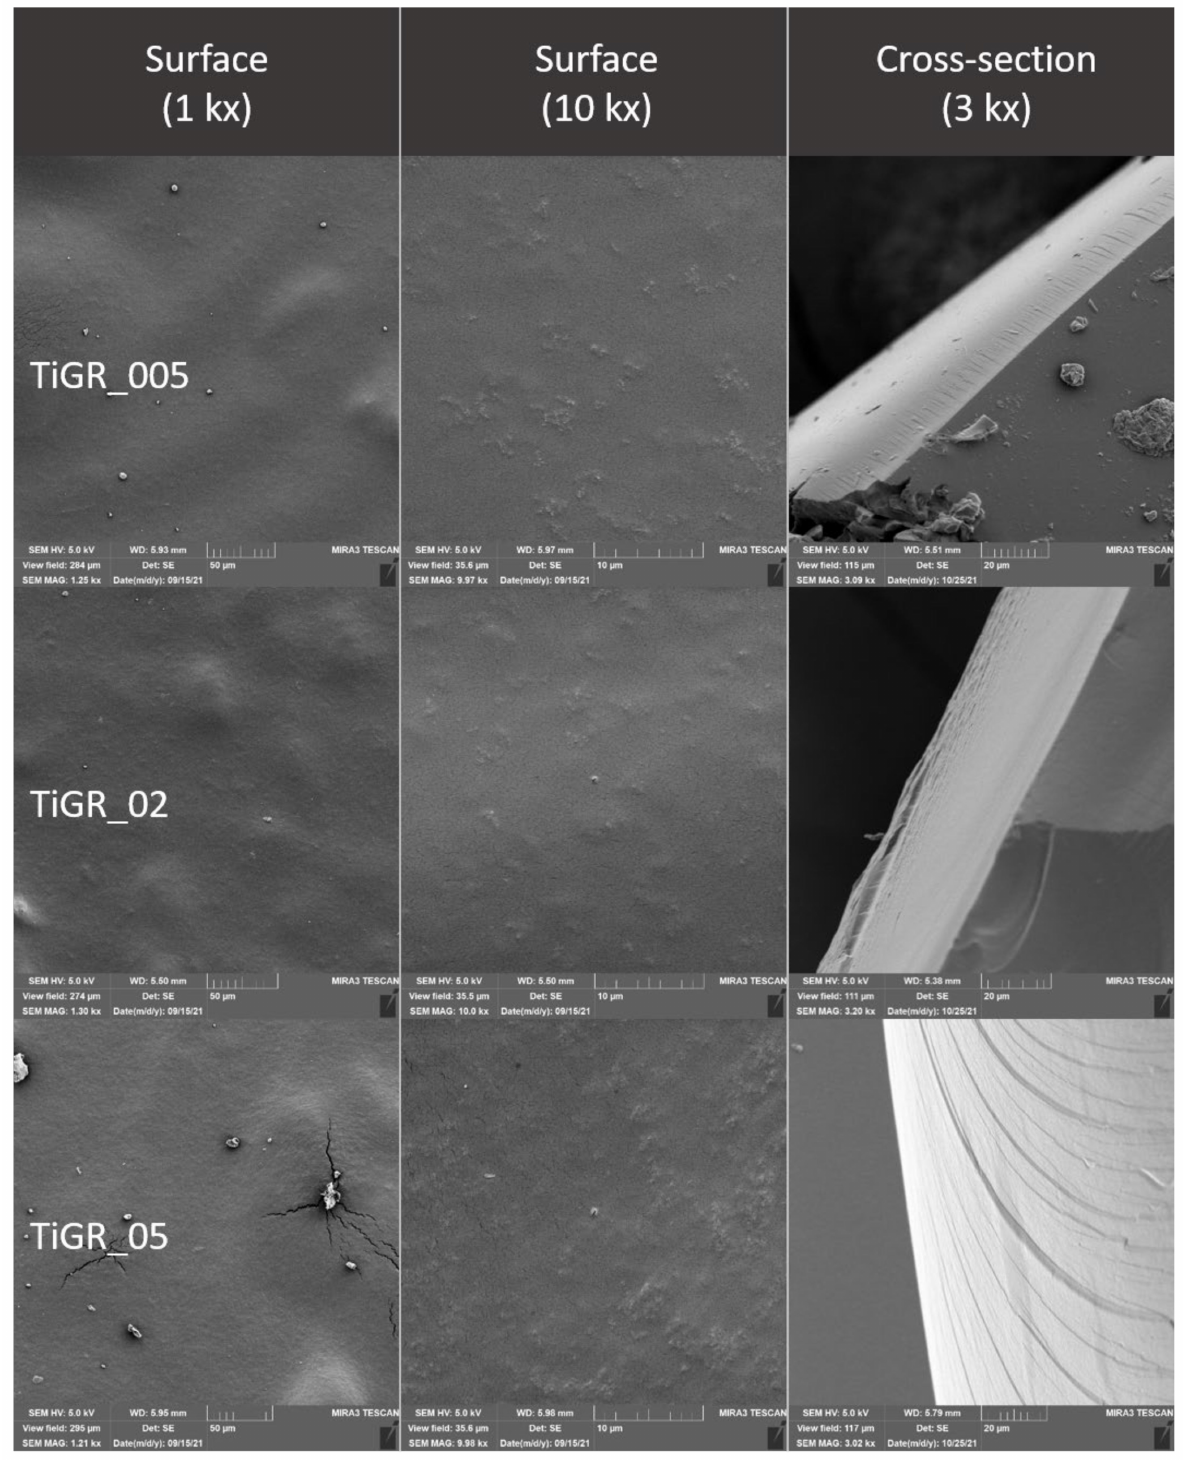
Figure 12. Surface and fracture microstructure of edible packaging with the addition of TiO 2 nanopar- ticles and grape